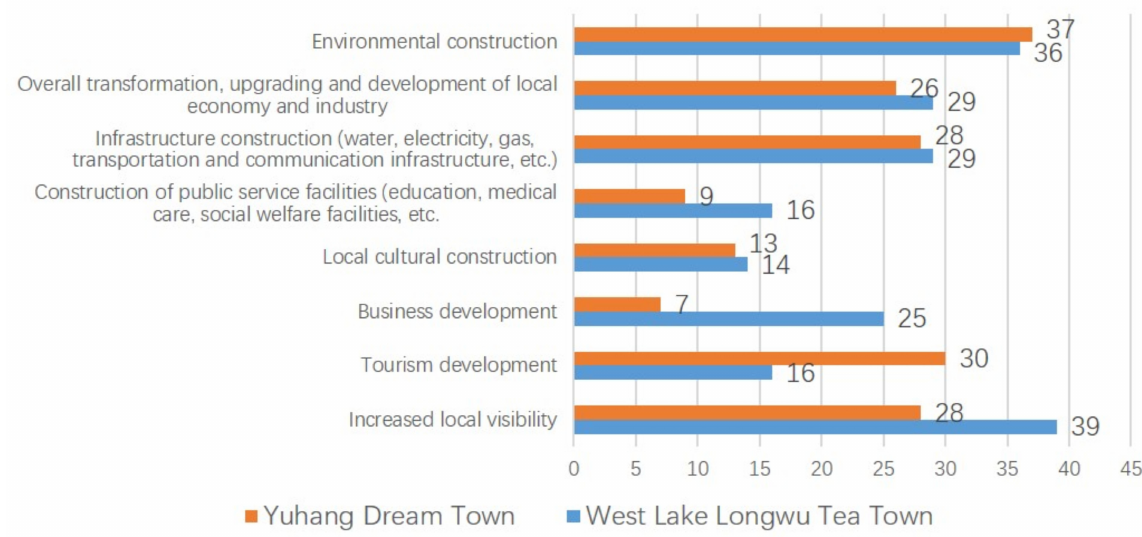
Figure 34. Frequency of selected aspects that respondents believe the local CT practice contribute the most promote local development (source: